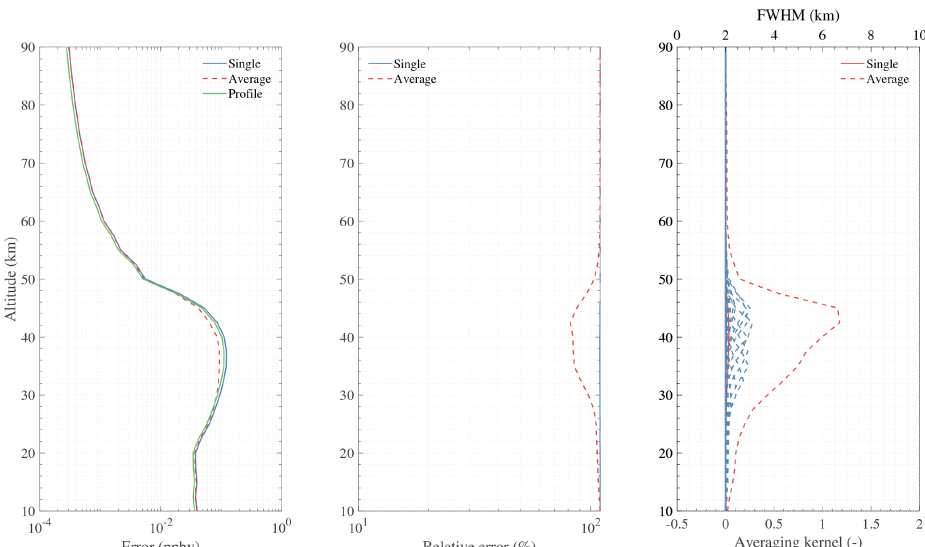
Figure 27. Simulation result of H 2 CO retrieval using 656.45GHz lines. “Single” and “Average” represent the retrieval error using different noise. “Profile” represents the typical profile used in the simulation. The black solid line in the last panel represents the FWHM (i.e. vertical